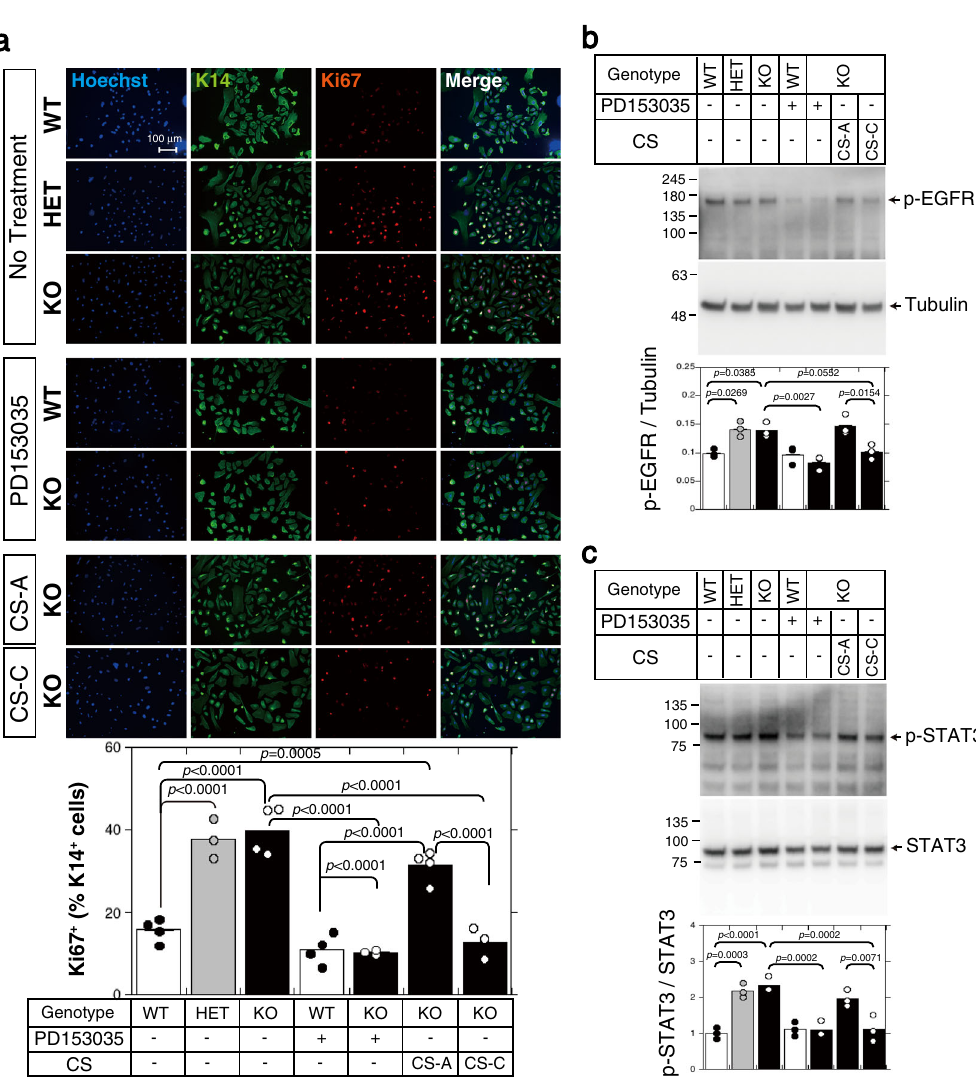
Fig. 5 EGFR-dependent keratinocyte proliferation is regulated by CS-C. a Keratinocytes (1 × 10 5 cells/well), isolated from C6st-1 WT, C6st-1 HE, and C6st- 1 KO epidermis, were cultured in the presence or absence of 5 μ M PD153035, 100 μ g/ml CS-A, and 100 μ g/ml CS-C. Cells were immunolabeled using anti- K14 and anti-Ki67 antibodies. The graph below indicates quanti fi cation of Ki67- and K14-double positive cells. Values are mean ± S.D. with n = 3-4 per group. Statistical signi fi cance was determined using one-way ANOVA with Tukey ’ s HSD test. Keratinocytes were treated with 5 μ M PD153035, 100 μ g/ml CS-A, and 100 μ g/ml CS-C as indicated. Cells were lysed and subjected to immunoblotting using b anti-phospho-EGFR and anti-tubulin antibodies, and c anti-phospho-STAT3 and anti-STAT3 antibodies. Tubulin and STAT3 were used as loading controls. The graphs below the blots show relative expression levels of phospho-EGFR and phosphor STAT3 in C6st-1 WT, C6st-1 HE, and C6st-1 KO keratinocytes subjected to the indicated treatments. Values are mean ± S.D. with n = 3 per group. Statistical signi fi cance was determined using one-way ANOVA with Tukey ’ s HSD